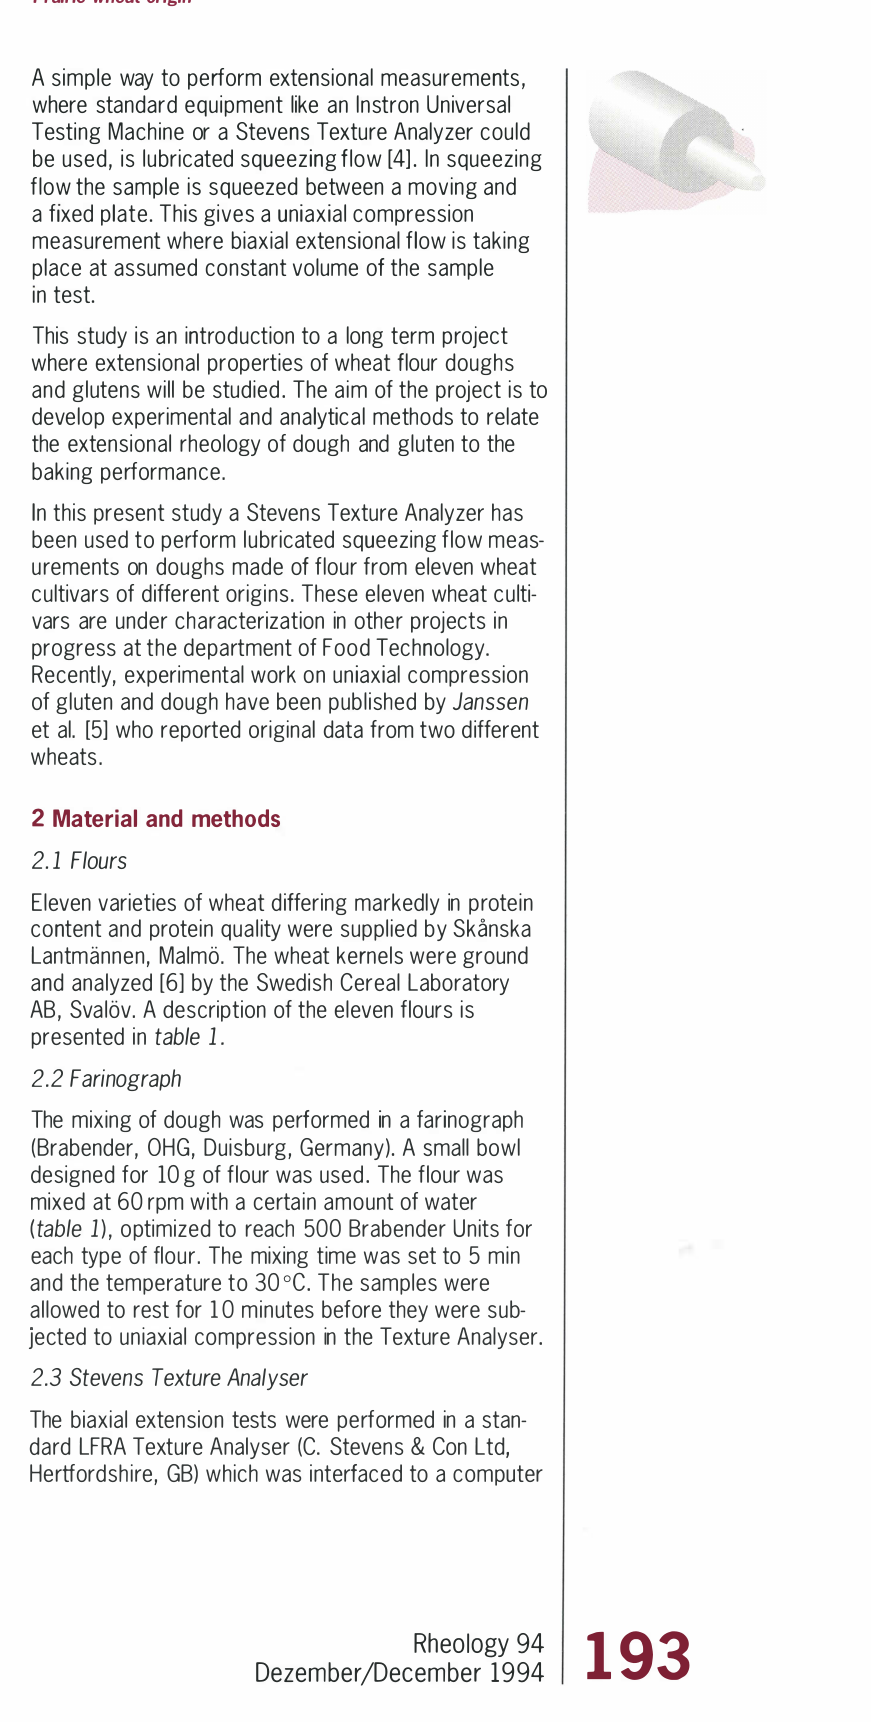
Fig.l: Force versus time curve taken from a lubricated squeezing flow experiment for a dough from Prairie wheat